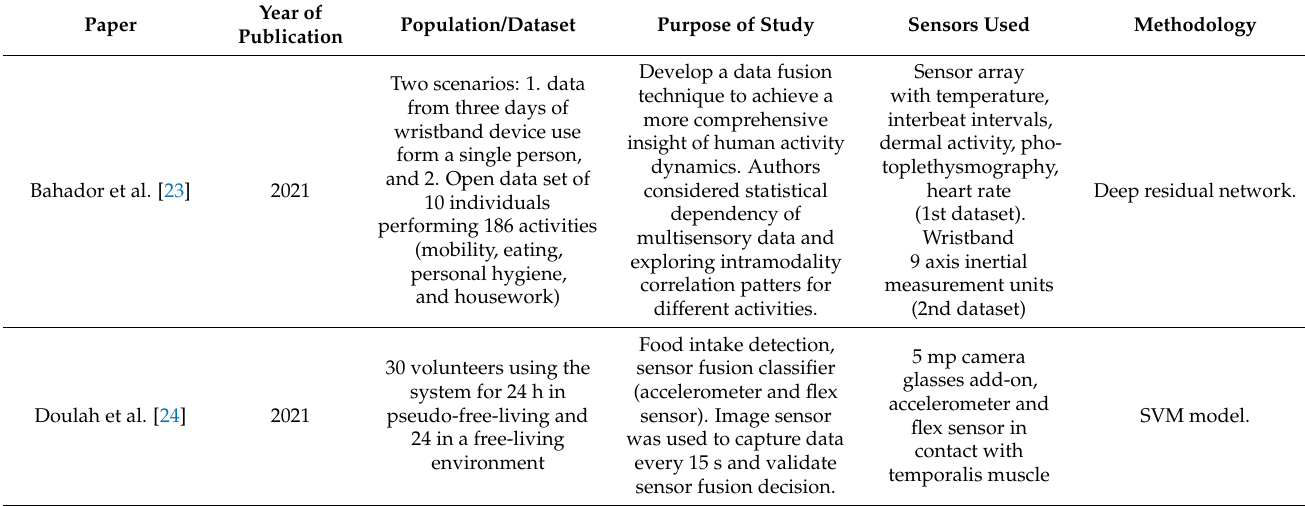
Table 1. The study